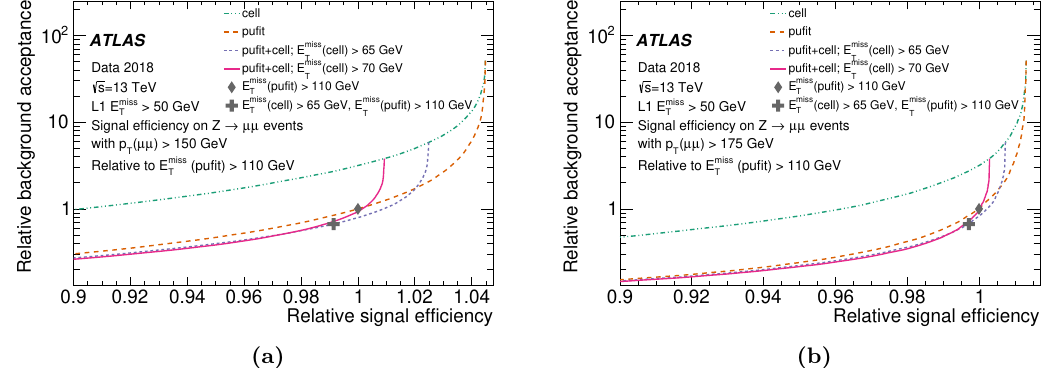
Figure 6. Relative background acceptance fraction vs. relative e(cid:14)ciency for two di(cid:11)erent p T ( (cid:22)(cid:22) ) thresholds: (a) p T ( (cid:22)(cid:22) ) > 150 GeV and (b) p T ( (cid:22)(cid:22) ) > 175 GeV for data recorded in the year 2018. Two of the curves show the performance of the stand-alone cell algorithm and the stand-alone pufit algorithm. The other two show combined algorithms each formed by requiring that the event satisfy both a (cid:12)xed threshold (either 65 GeV or 70 GeV as shown in the legend) for the cell algorithm and a pufit E miss T